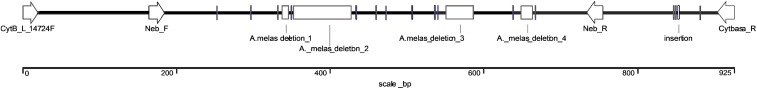
Schematic illustration of the comparison of species-specific sequences from Ameiurus nebulosus and Ameiurus melas.The arrows indicate the annealing locations of the original and our species-specific primers. The clear boxes show the deletions, the gray bars are single base pair substitutions or the 1 bp insertion in Ameiurus melas sequence compared to Ameiurus nebulosus.